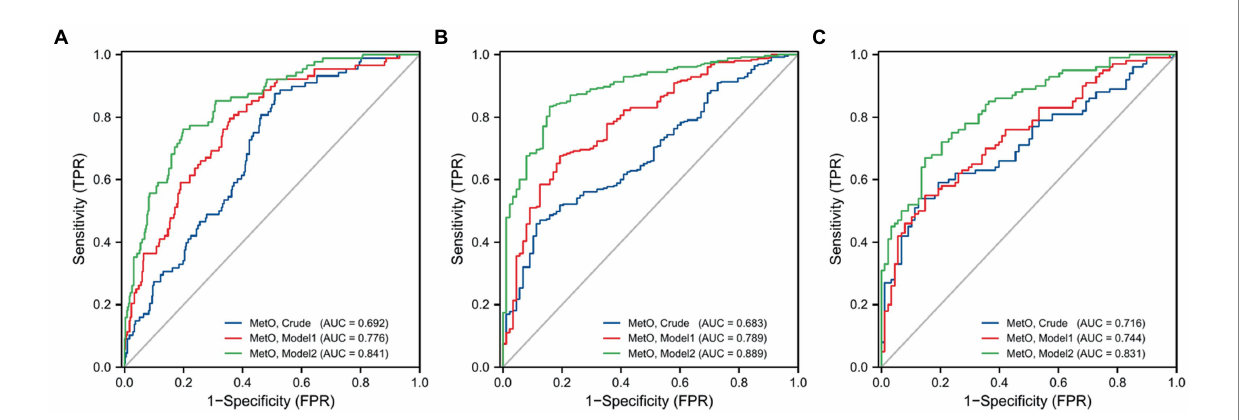
FIGURE 3 ROC curves of MetO in different models for the risk of MMD and its subtypes. (A) MMD overall; (B) Ischemic-type; (C)